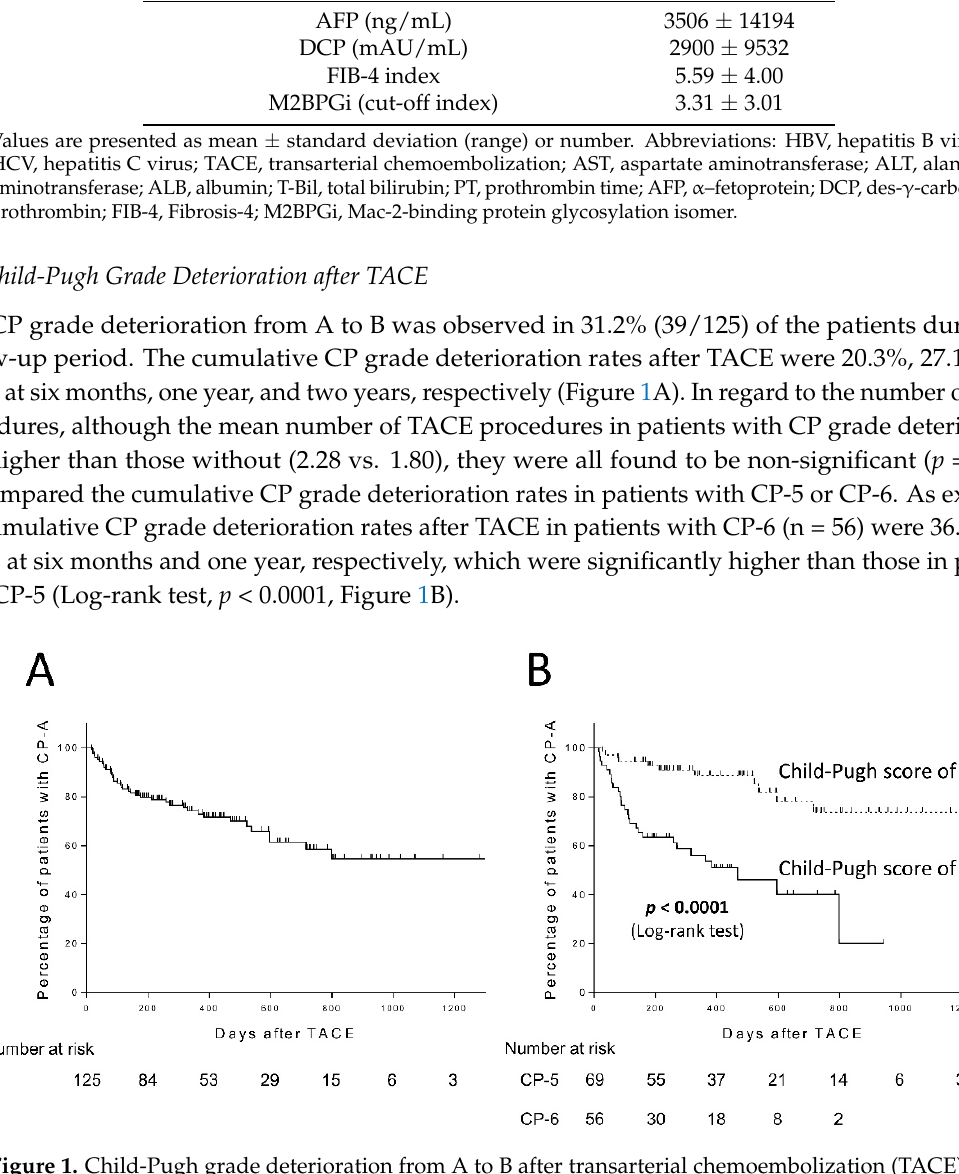
Figure 1. Child-Pugh grade deterioration from A to B after transarterial chemoembolization